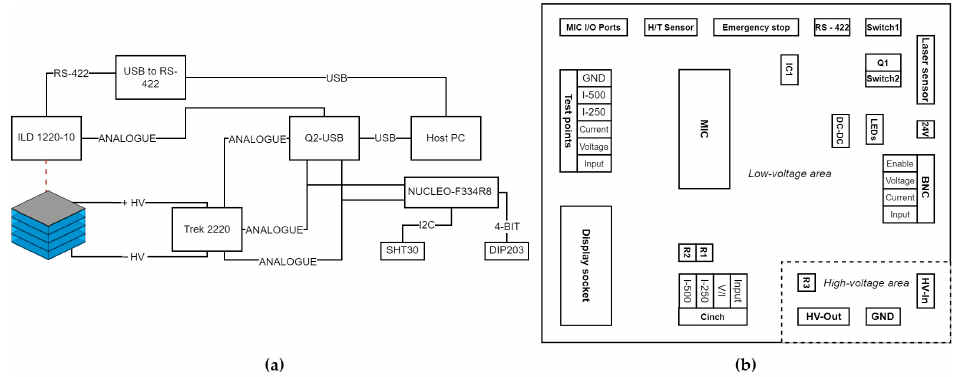
Figure 3. Schematic layout ( a ) test bench ( b ) PCB.